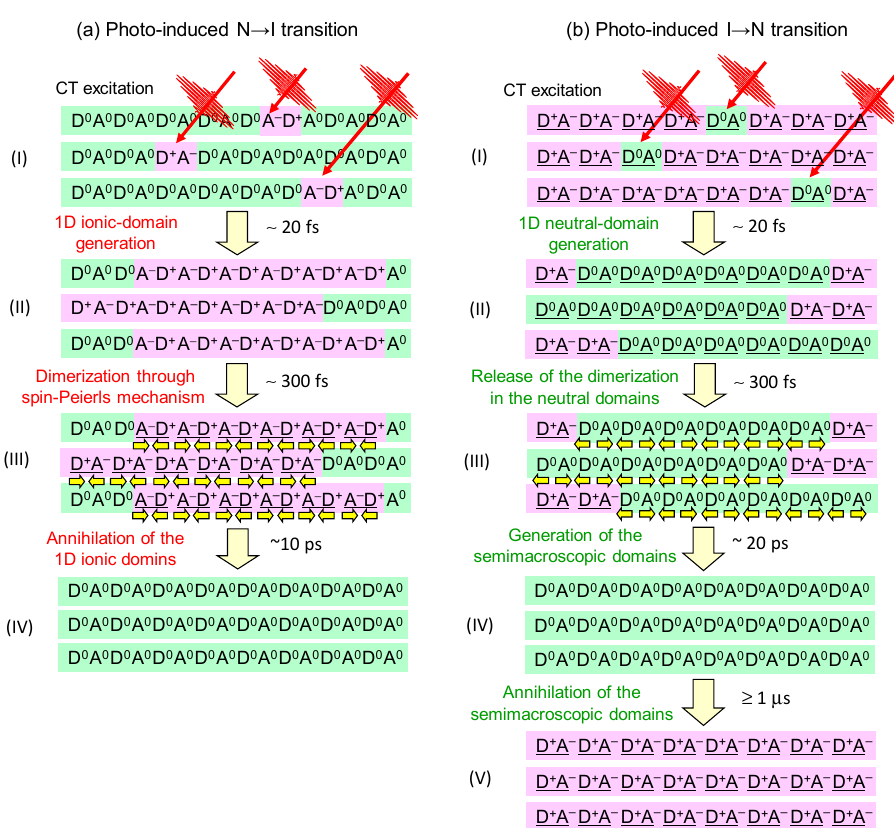
Figure 12. ( a , b ) Schematics of ( a ) photoinduced N -to- I transition and ( b ) photoinduced I -to- N transition in TTF-CA. D 0 ( A 0 ) and D + ( A − ) represent neutral and ionic donor (acceptor) molecules, respectively. Underlines show dimers.